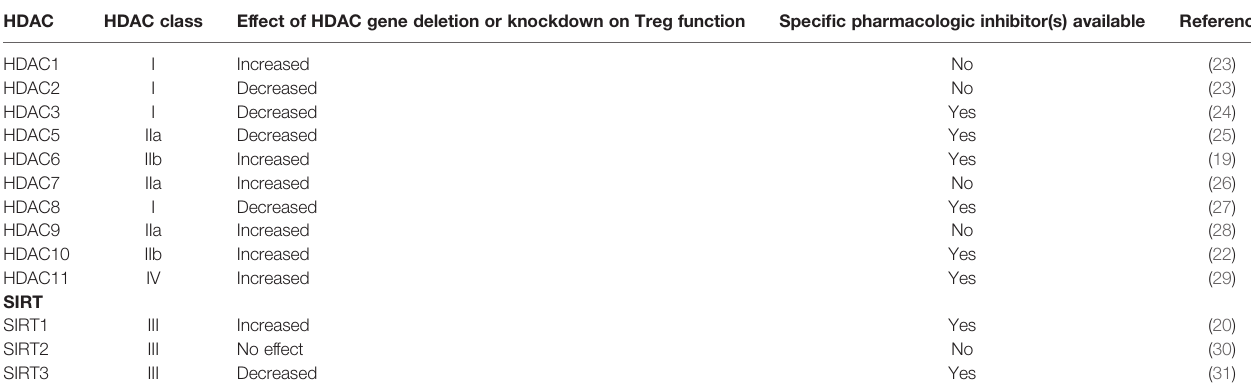
TABLE 1 | Effects of HDAC targeting in Treg